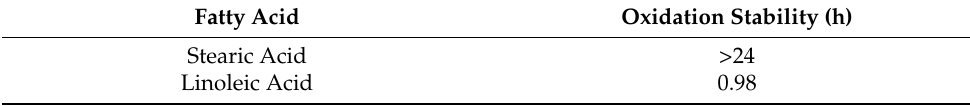
Table 4. Stability of fatty acid oxidation using the Rancimat test method.